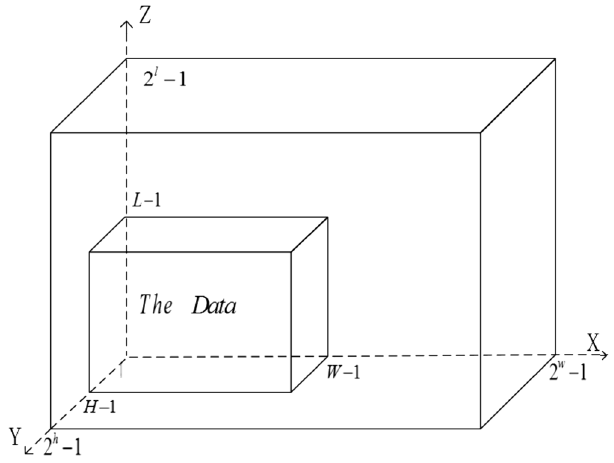
Figure 1. 3-D data.